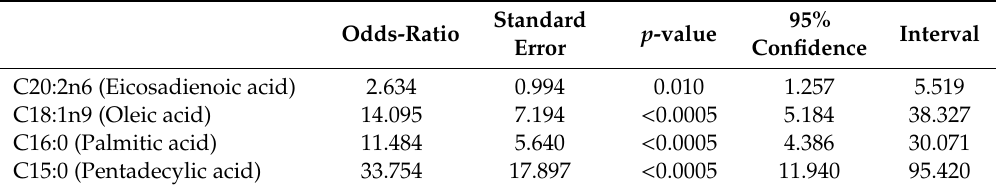
Table 4. Odds ratio of being a case (AMD) in the highest quartile, using the lowest quartile as reference. Only those with a statistically significant results are